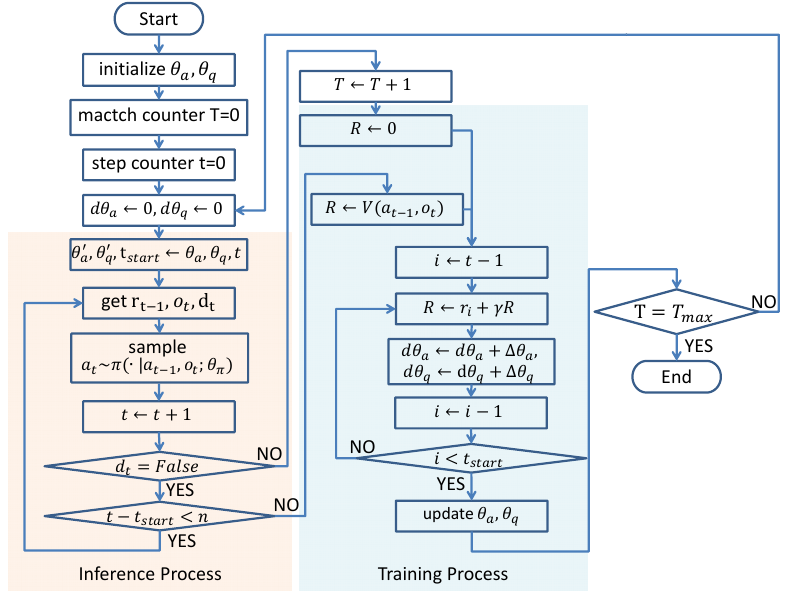
Figure 4. The algorithm flow chart of MA3C. The inference and training processes are executed in turn until the total number of matches, T , reaches T max